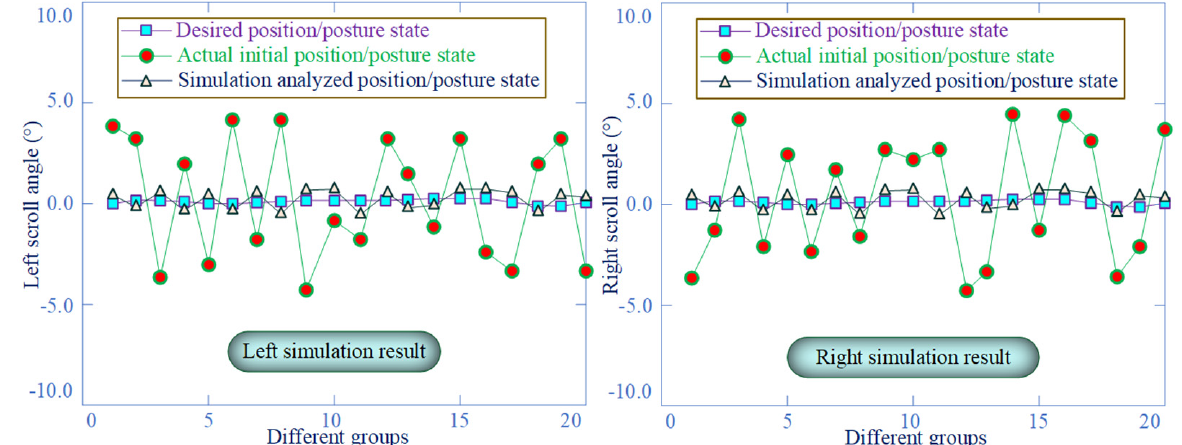
Figure 13. Simulation results of scroll angles.